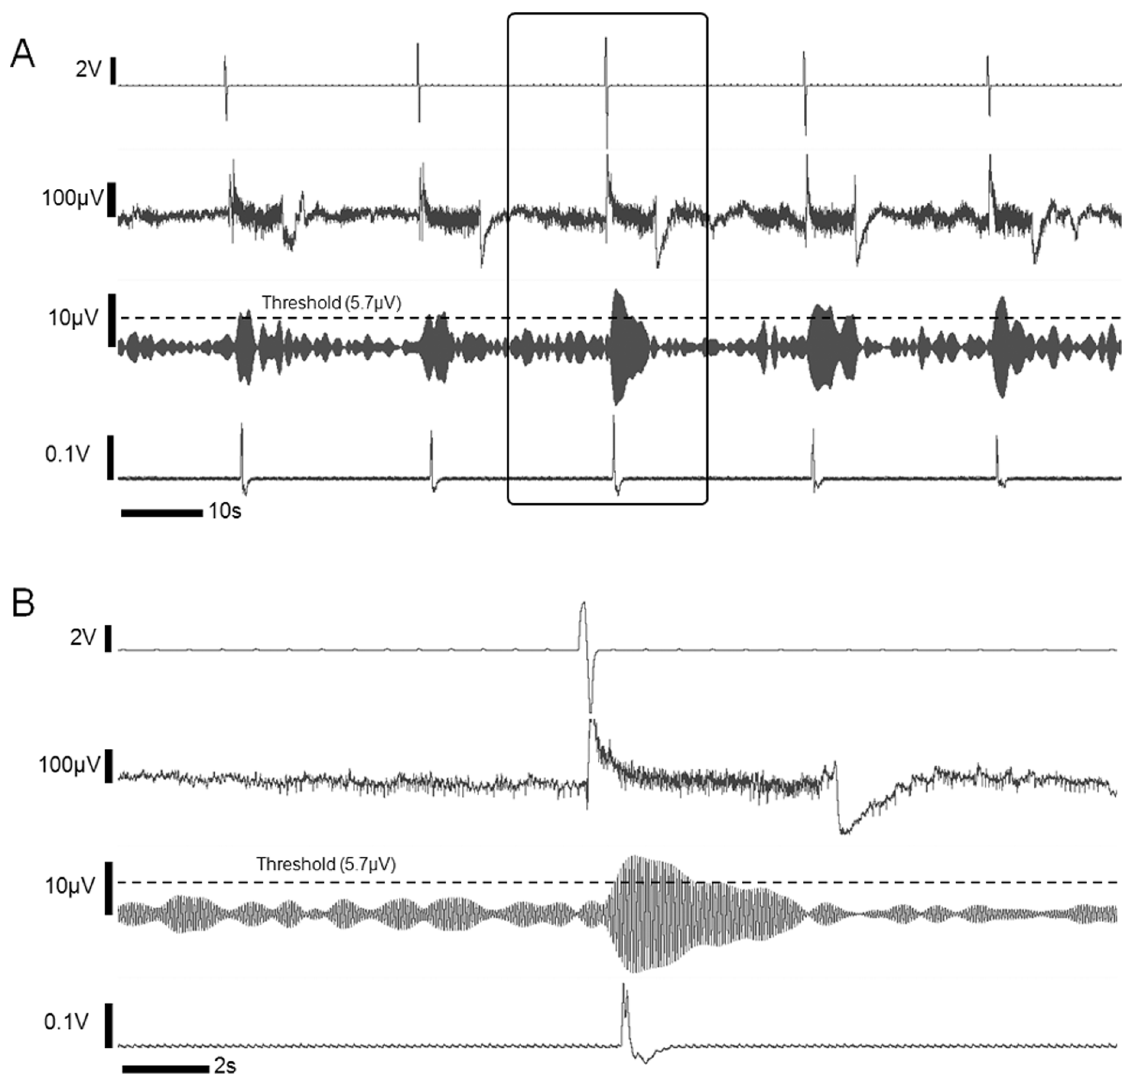
Figure 3. Example of bio-signals obtained from the BBI operation. (A) Initiation of operator intension (as signaled by the finger movement; top), the raw EEG data (the 2 nd row), the filtered EEG data at 15 Hz (the 3 rd row), and the detected rat tail movement (the last row). The threshold condition for the filtered EEG is shown in dotted line. (B) The time resolved plot of the box shown in (A). doi:10.1371/journal.pone.0060410.g003 PLOS ONE |